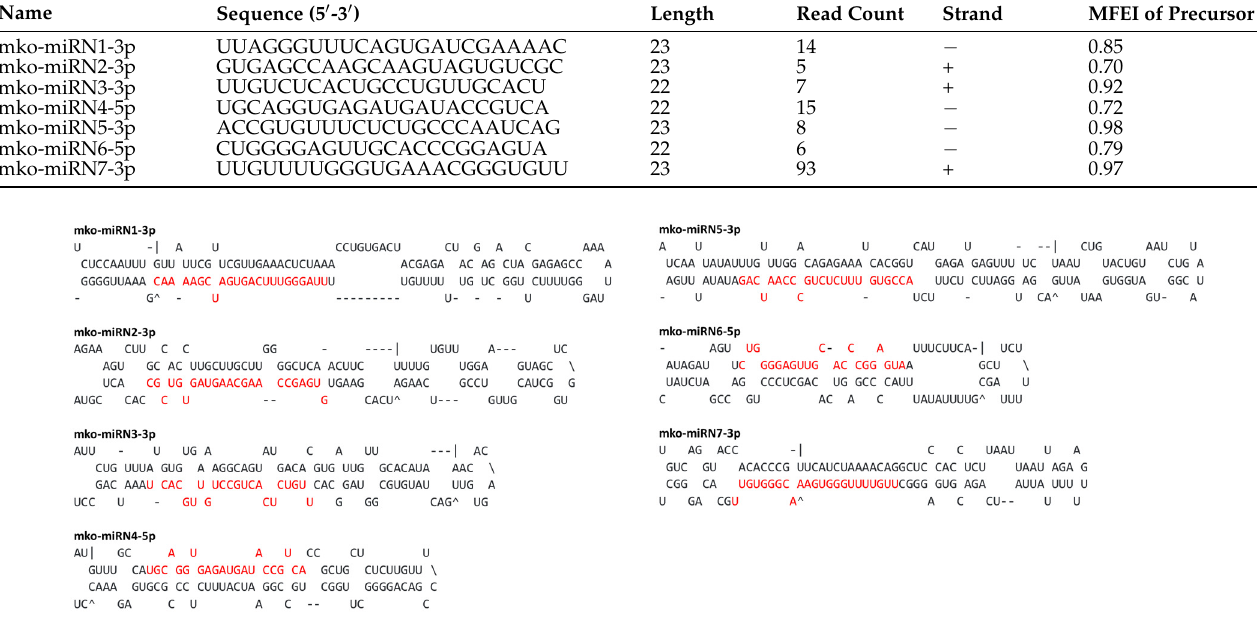
Table 3. Potential novel miRNA candidates identified from M. koenigii .